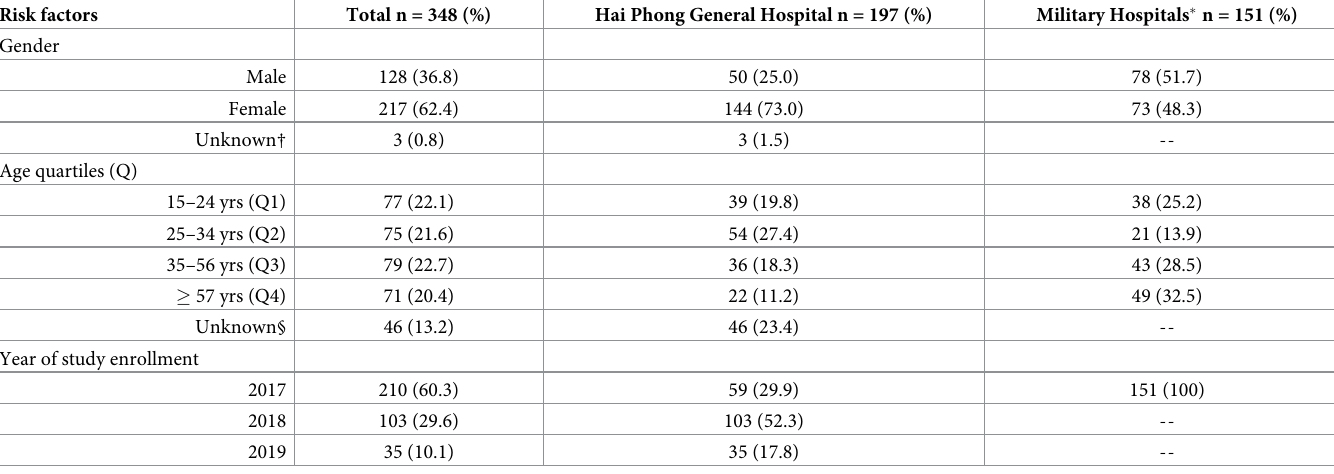
Table 1. The distribution of study subjects with severe acute respiratory illness by age, gender, year of study enrollment, and hospital in the Hanoi area.